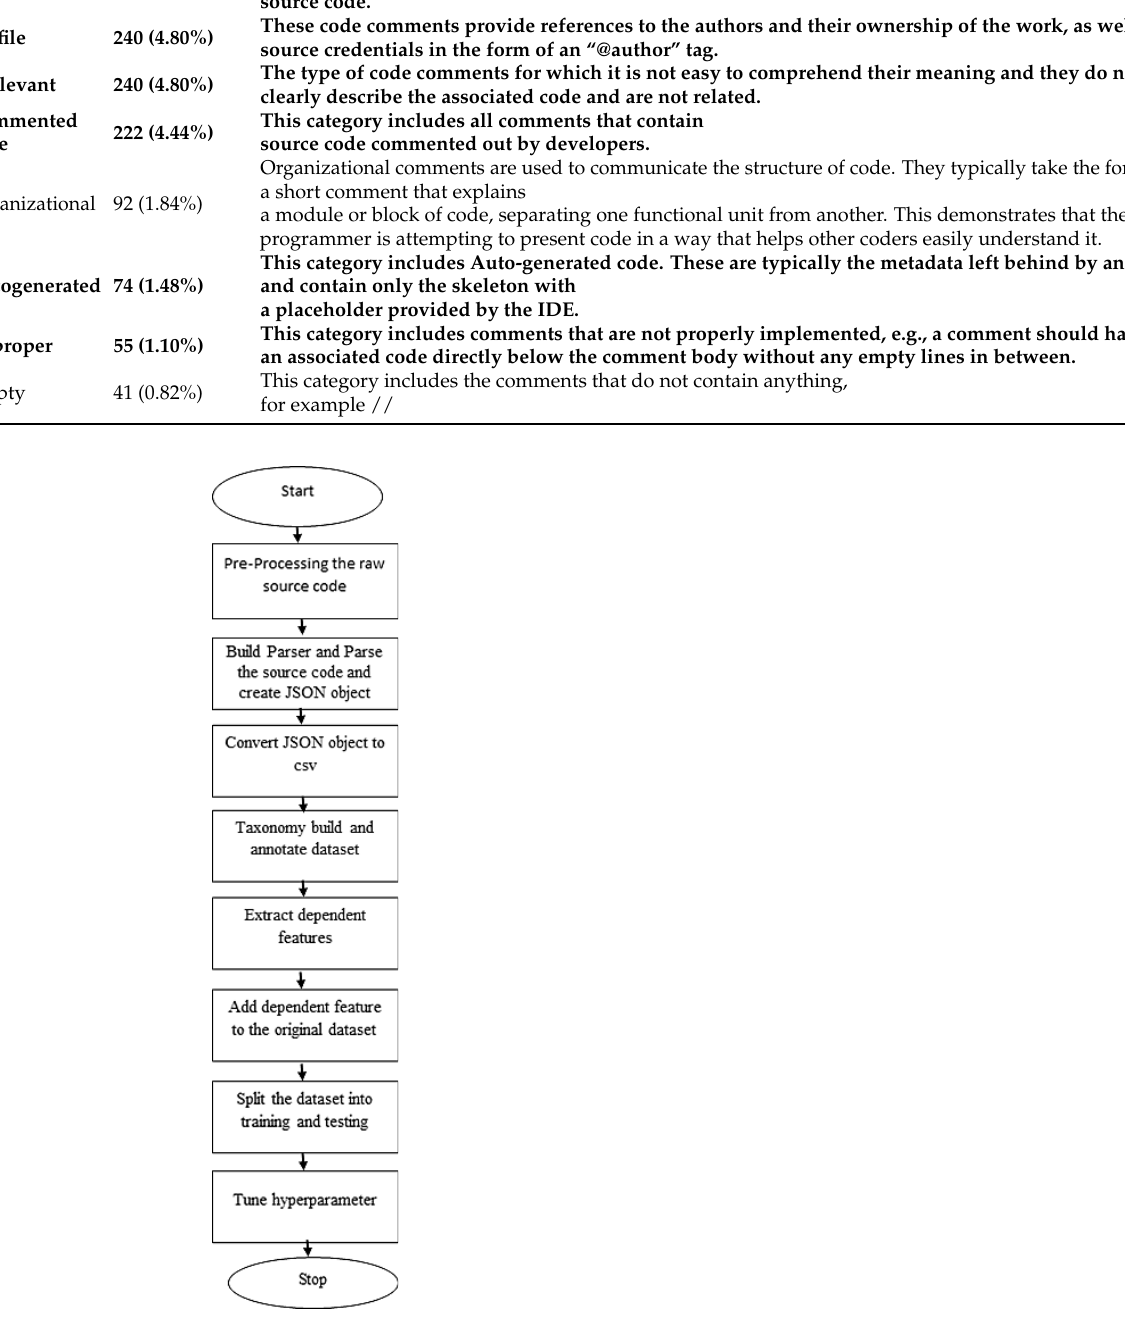
Figure 2. Flow chart of classification of code comments.